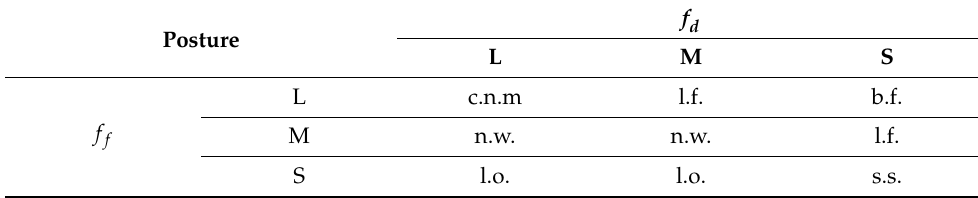
Table 3. Posture while moving